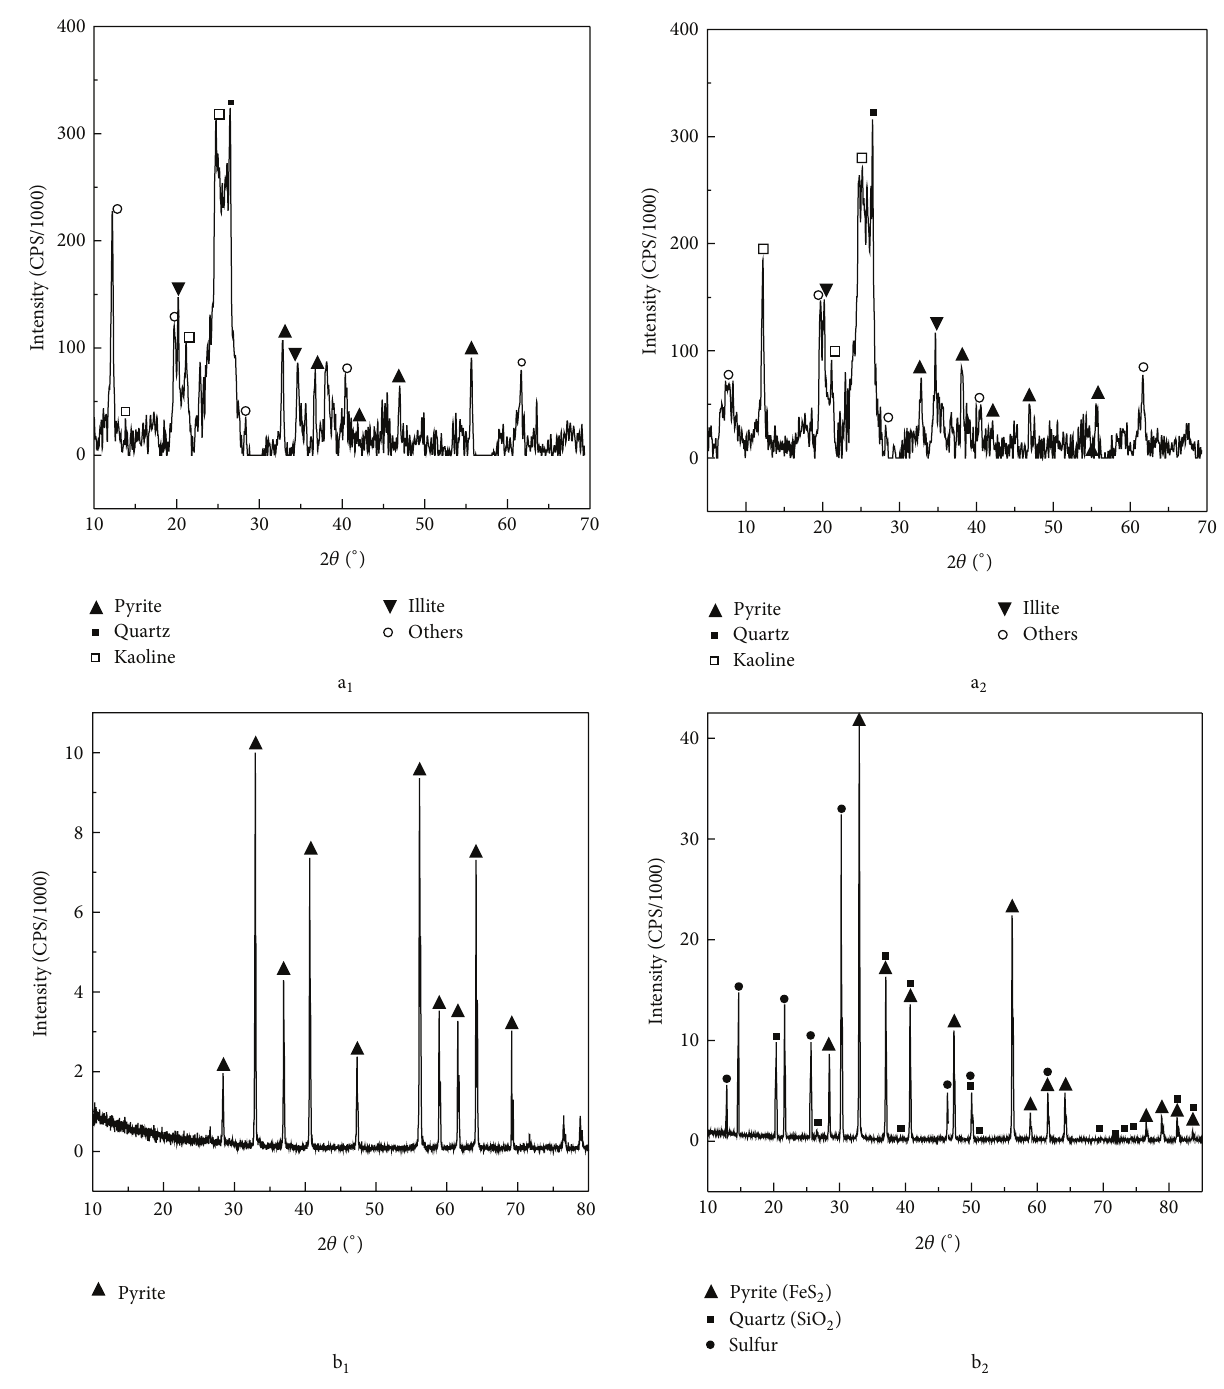
Figure 4: XRD analysis of coal before (a 1 ) and after (a 2 ); pyrite before (b 1 ) and after (b 2 ) processed with A.